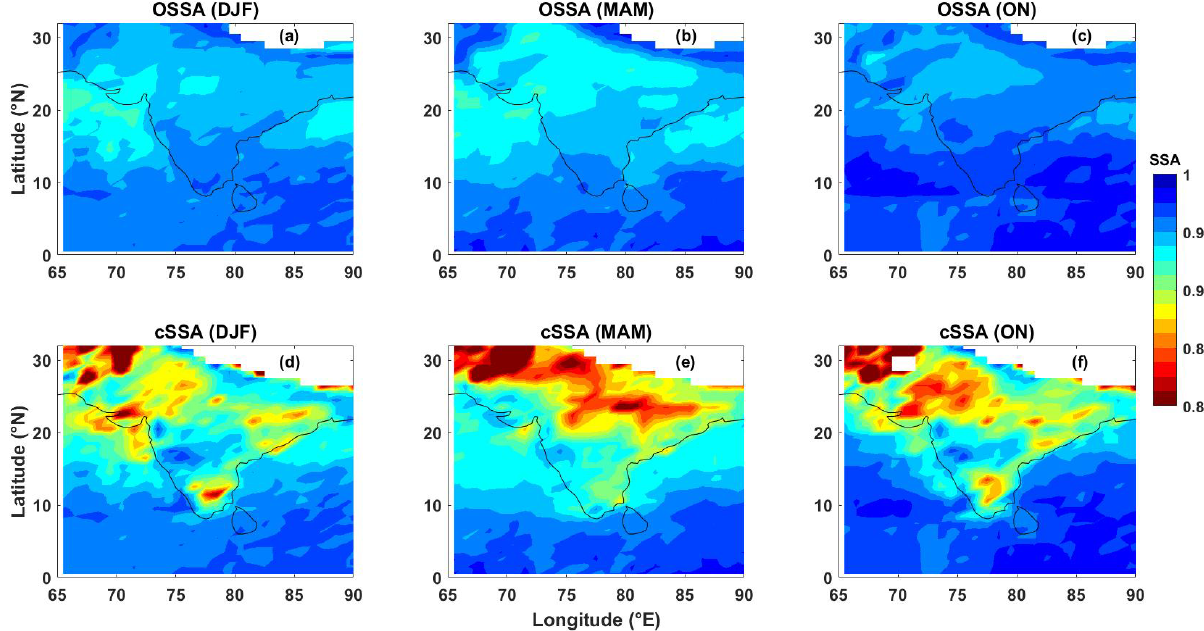
Figure 2. Spatial map of OMI SSA (a, b, c) and cSSA (combined SSA; d, e, f ). The left, middle, and right panels represent the seasons DJF, MAM, and ON respectively. Table 1. Mean OMI SSA corresponding to the two dashed rectangles (on the west and east of the Indian mainland) shown in Fig. 1. The suffixes L and O correspond to land and ocean respectively. Region DJF L MAM L ON L DJF O MAM